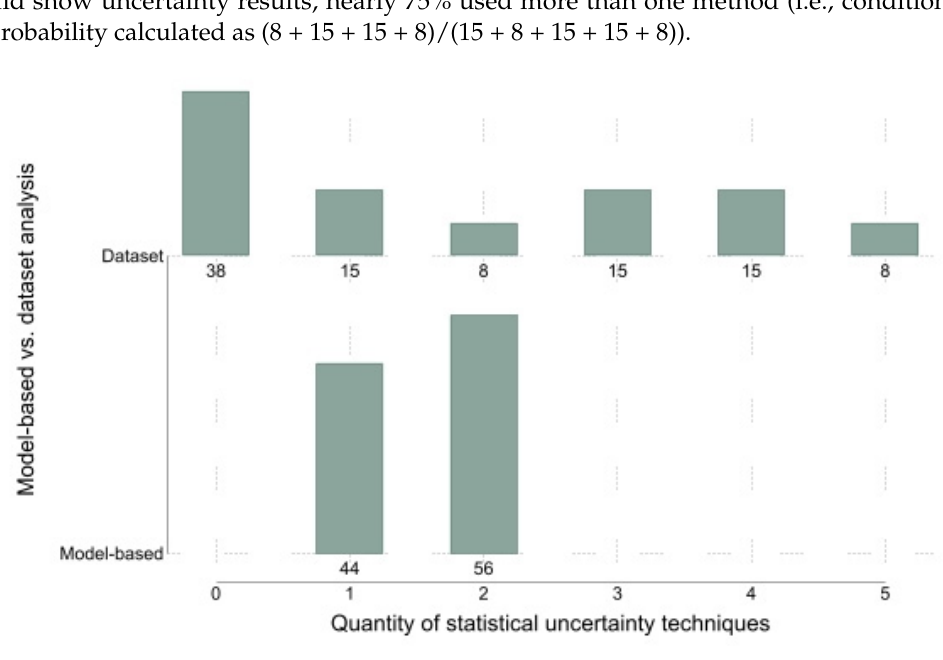
Figure 4. Quality of statistical uncertainty techniques used by analysis type.